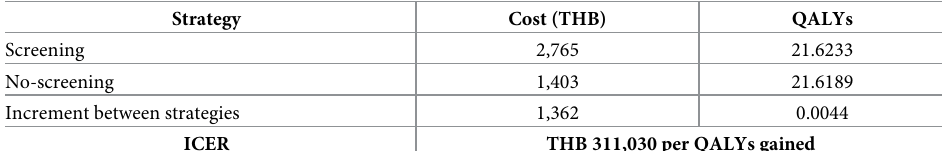
Table 2. Lifetime costs and QALYs of screening versus